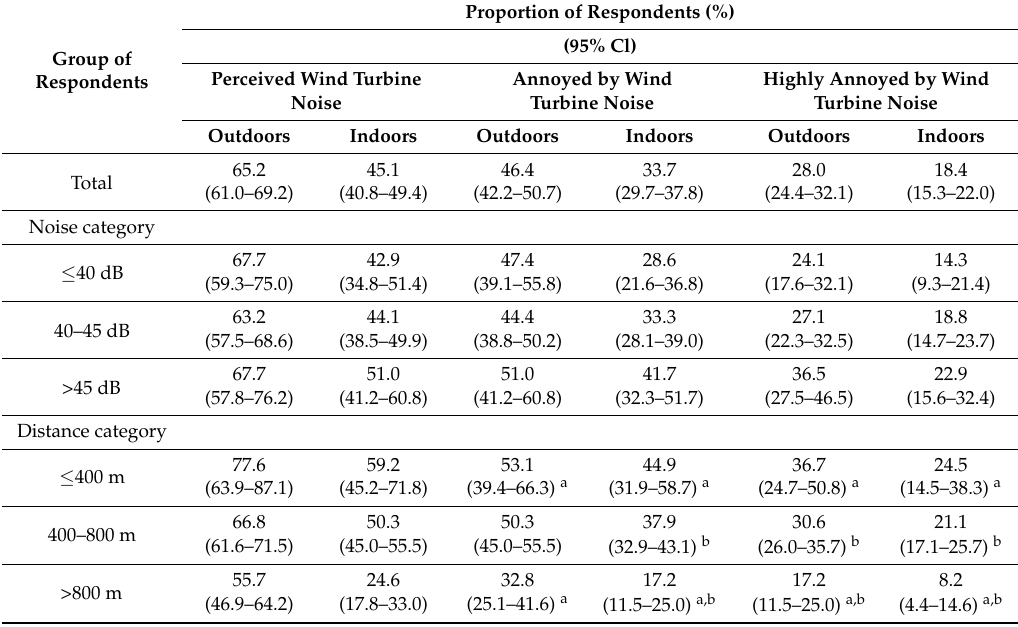
Table 6. Proportions (with 95% confidence intervals) of respondents who noticed and were annoyed or highly annoyed by the wind turbine noise in total and in each of the noise and distance categories 1